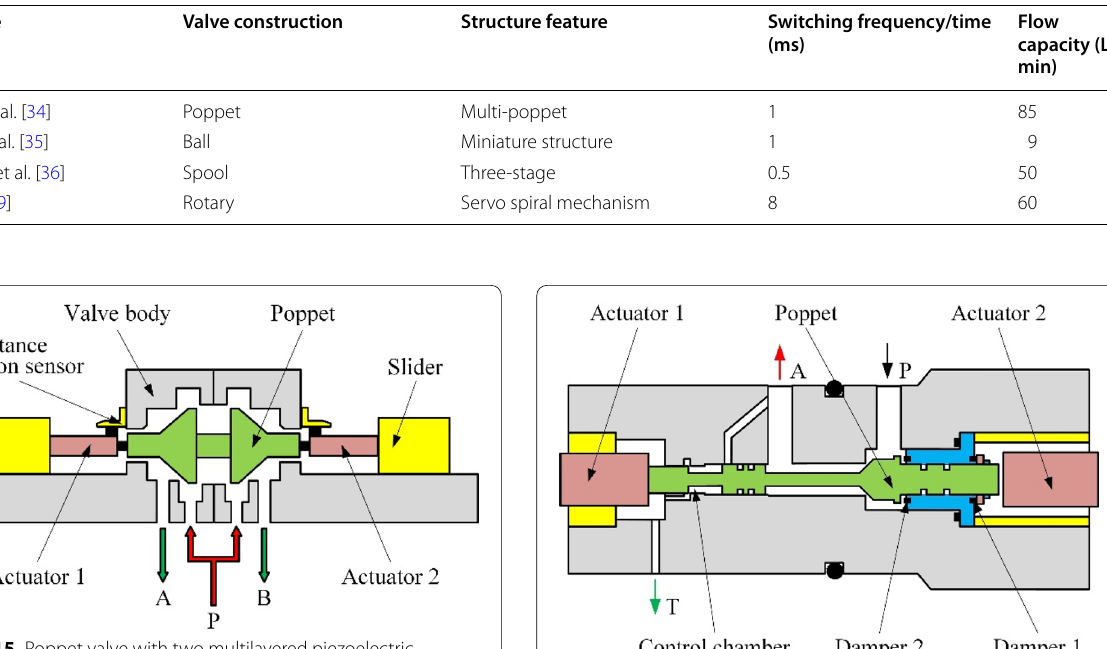
Table 2 Summary of the pilot operated HSVs with innovative structures